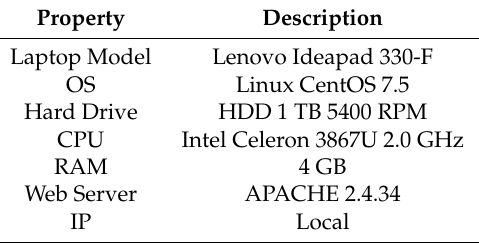
Table 1. The configuration of the